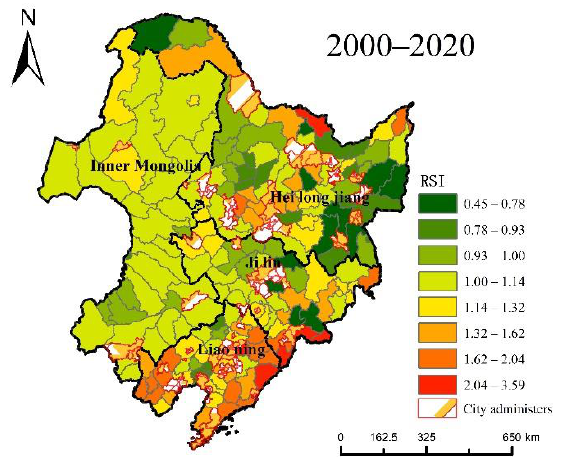
Figure 2. Spatial and temporal distribution pattern of rural settlement size in Northeast China.